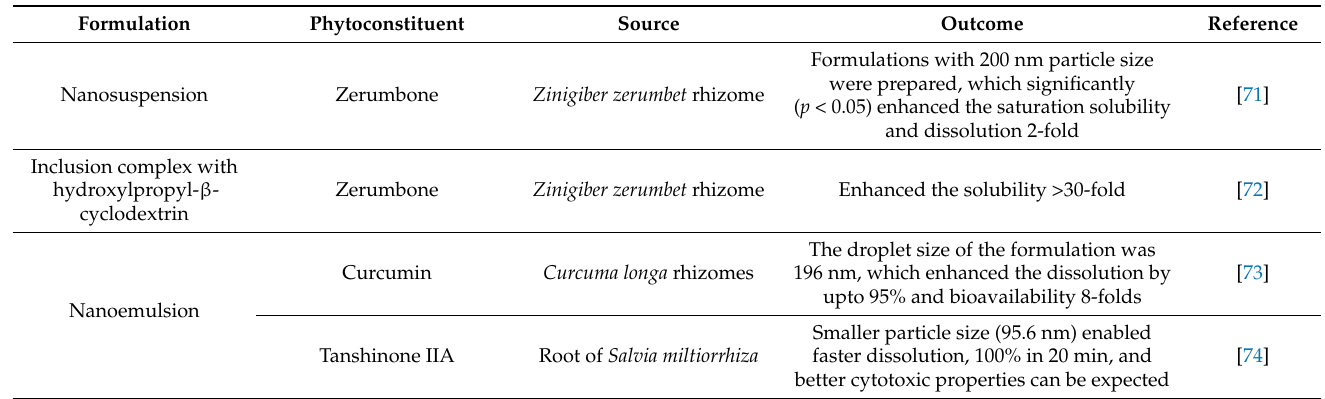
Table 2. Nanoparticle formulations of phytoconstituents with regard to dental diseases that show improved physicochemical and therapeutic